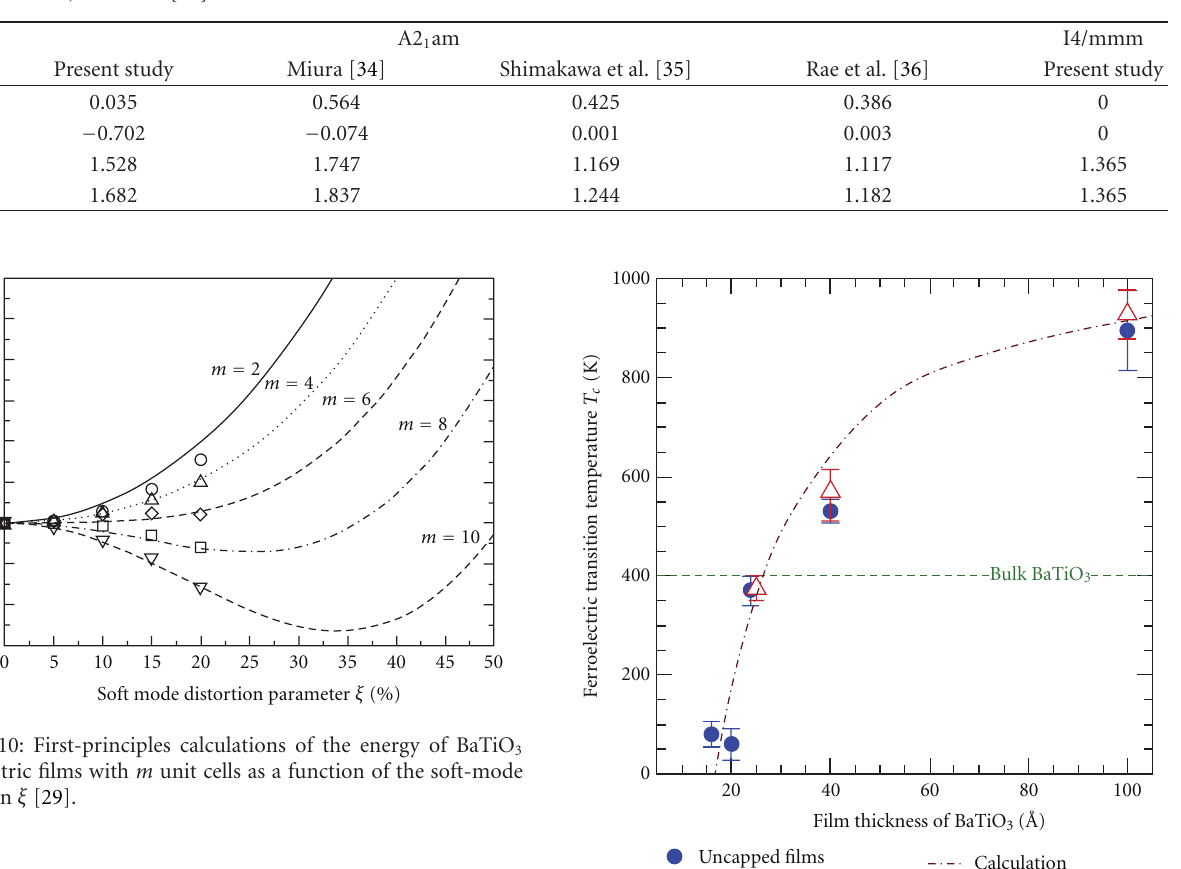
Table 3: Estimated dipole moment of TaO 6 octahedron of the ferroelectric phase at 300 K (A2 1 am) and the high-temperature paraelectric phase (I4/mmm) at 1000K [25].